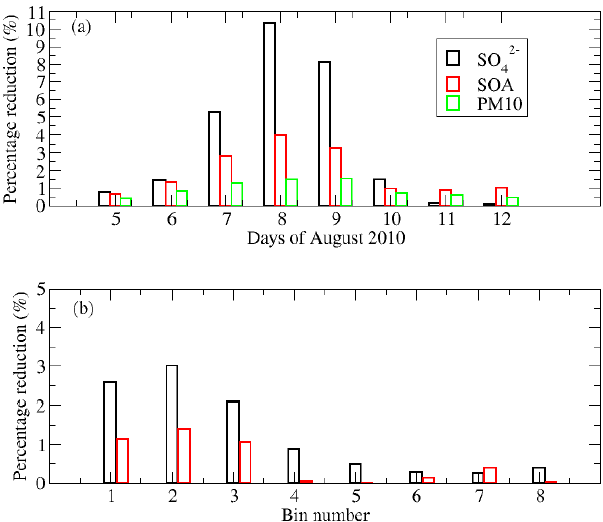
Figure 10. (a) Daytime average percentage reduction of the near- surface concentration of sulfates, secondary organic aerosols and PM 10 over Moscow due to the aerosol feedback. (b) Repartition of this sulfate and SOA mass reduction between the eight aerosol size bins for the 8